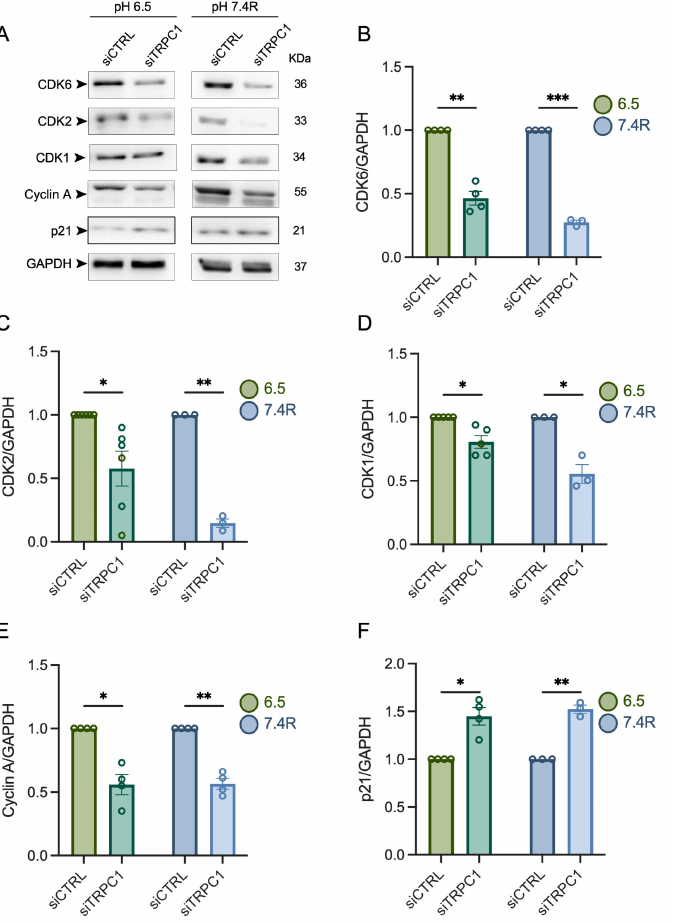
Figure 5. TRPC1 silencing decreases the expression of CDK6, ‐ 1, ‐ 2, and cyclin A and increases the expression of p21 CIP1 to a greater extent in acid recovery conditions. ( A ) Western blot analysis of relevant cyclin ‐ dependent kinase complexes and cyclins and their inhibitor p21 CIP1 from cells grown under acid adaptation (6.5) or acid recovery conditions (7.4R). ( B ) Quantification of Western blot analysis representing the expression of CDK6, ( C ) CDK2, ( D ) CDK1, ( E ) cyclin A, and ( F ) p21 CIP1 in siTRPC1 lysates compared to siCTRL lysates from PANC ‐ 1 cells grown under acid adaptation (6.5) or acid recovery (7.4R) conditions ( n = 3 − 6). Welch’s correction t ‐ test was used to determine the significant difference between siCTRL and siTRPC1. *, **, and *** indicate p < 0.05, 0.01, and 0.001, respectively. The uncropped blots are shown in File S1.